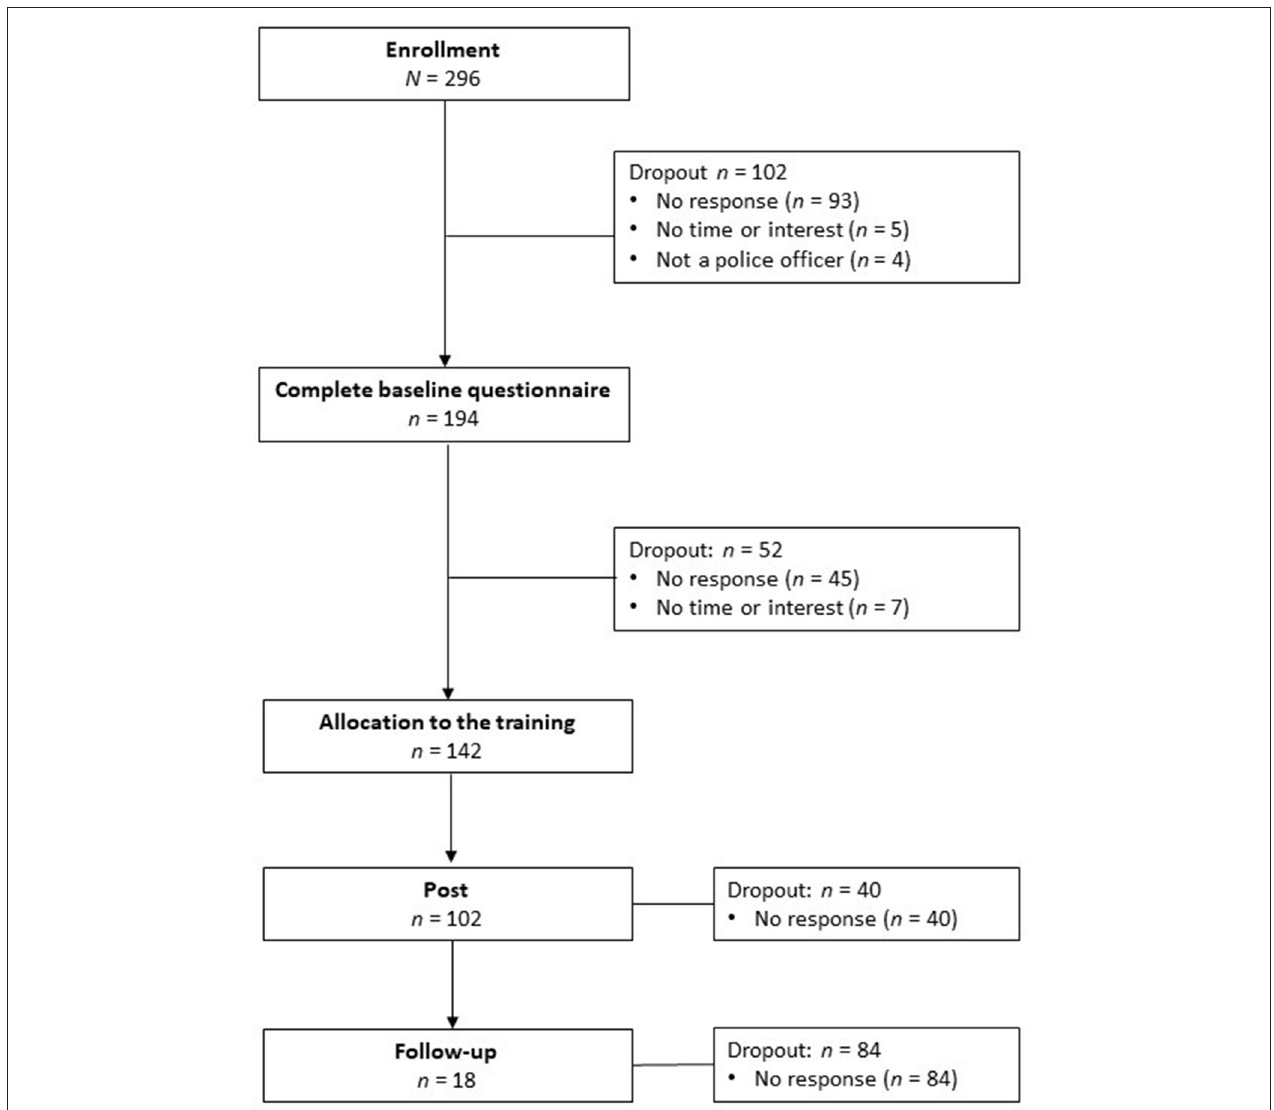
FIGURE 1 | Flowchart of